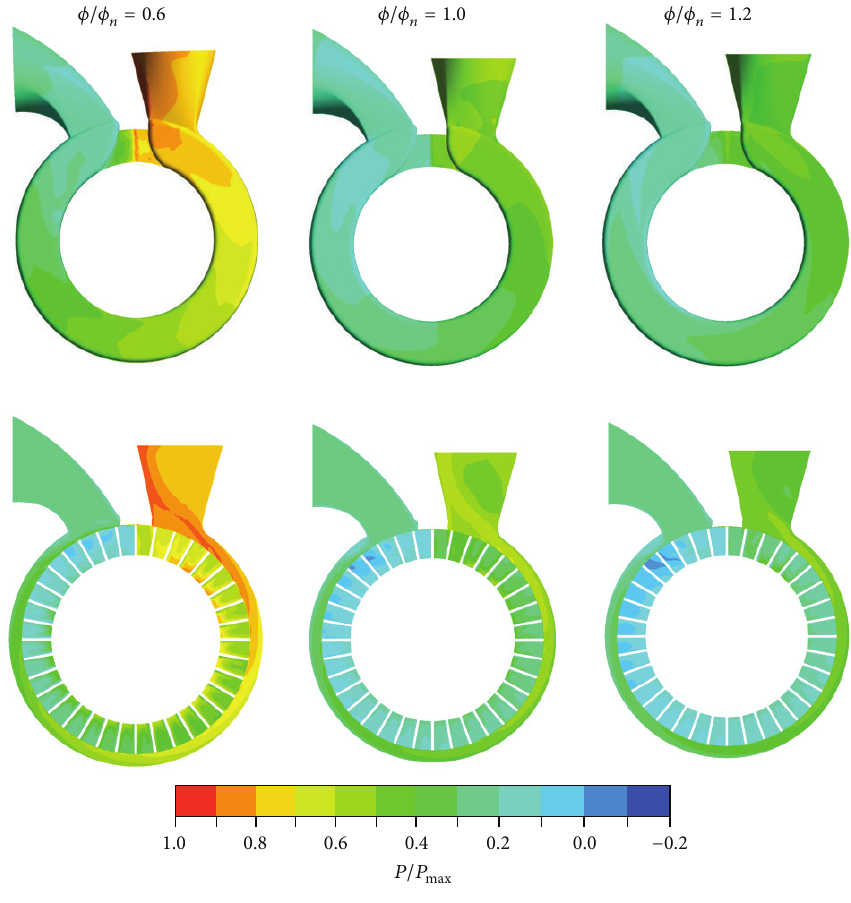
Figure 11: Pressure contours at 𝜙/𝜙 𝑛 = 0.6 , 𝜙/𝜙 𝑛 = 1 , and 𝜙/𝜙 𝑛 = 1.2 .